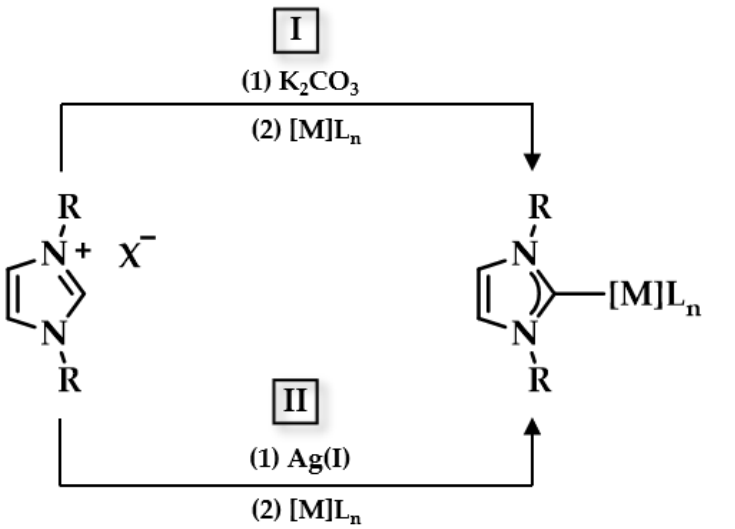
Figure 9. Synthesis routes towards NHC complexes I via mild base and II transmetalation with Ag 2 O.